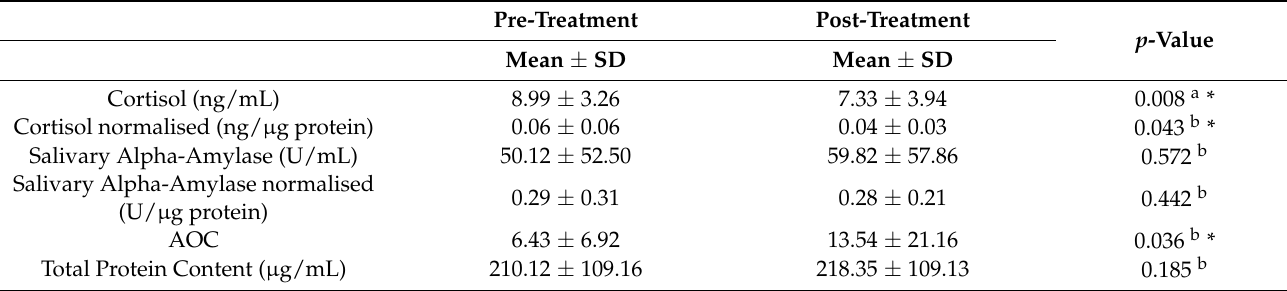
Table 1. Values of salivary parameters evaluated before and after dental treatment.